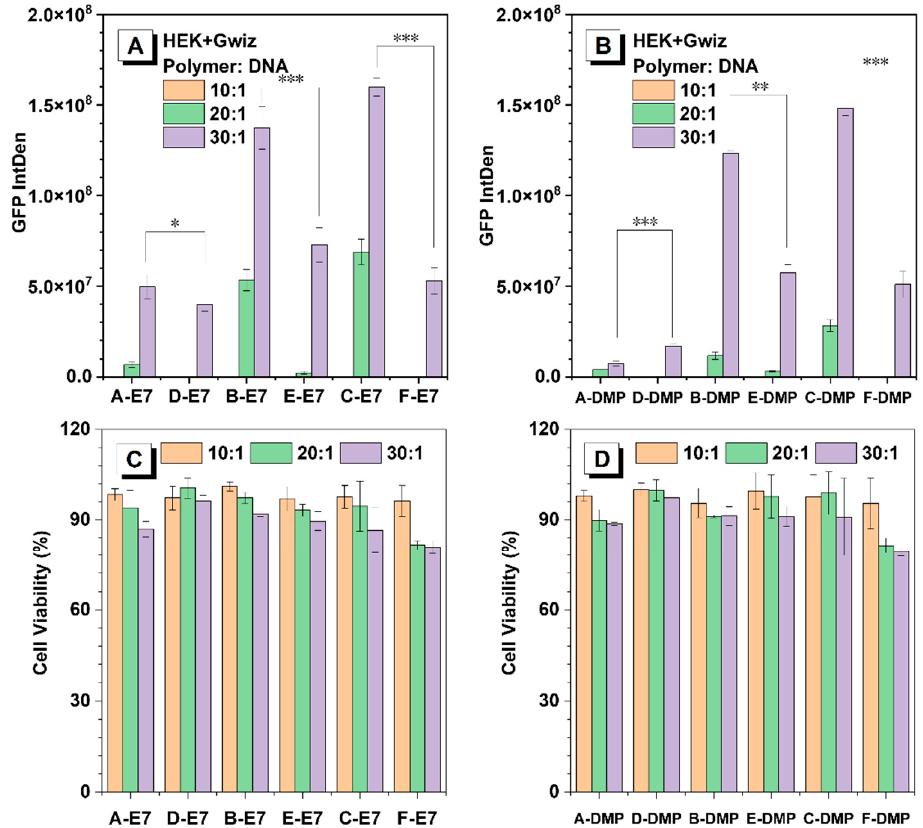
Figure 4. In vitro transfection results of HEK293 cells 48 h post-transfection. ( A ) GFP expression of HEK293 cells post-transfection by E7 end-capped HPAE-based polyplexes. ( B ) GFP